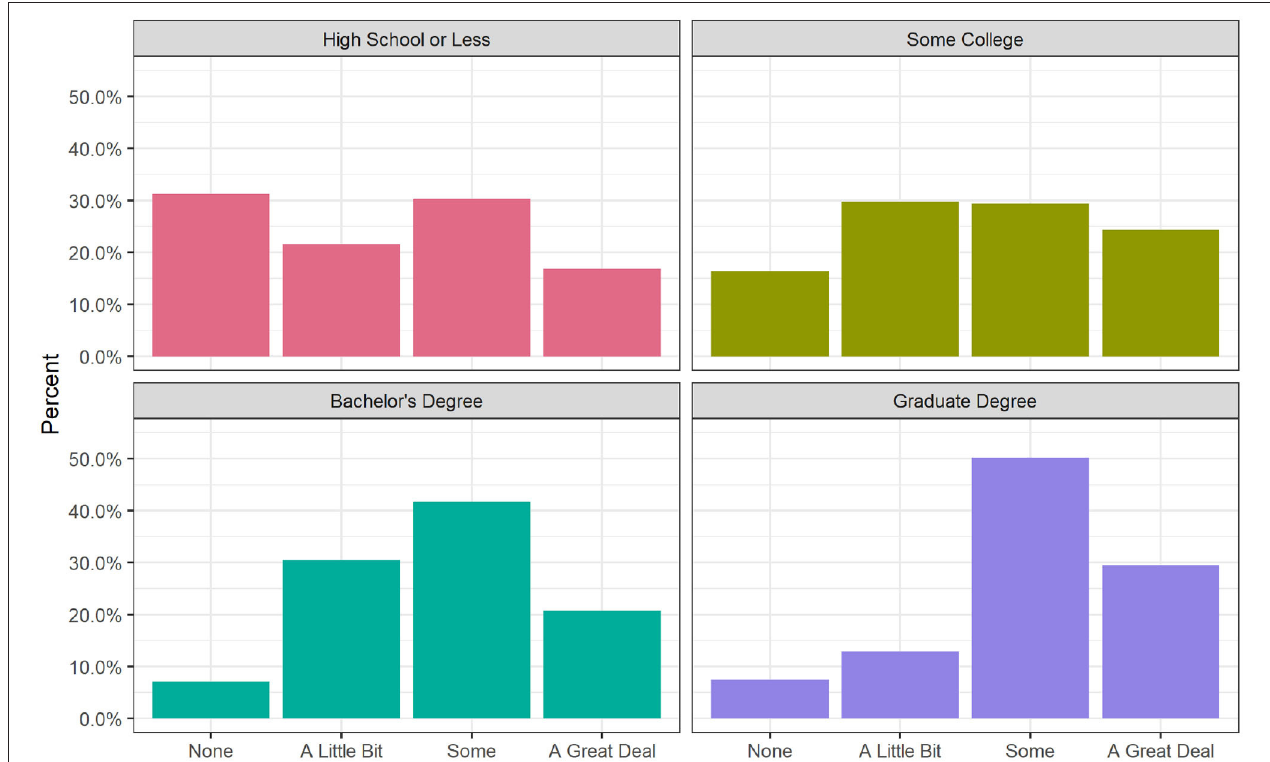
FIGURE 1 | Attention to concussion news by educational attainment